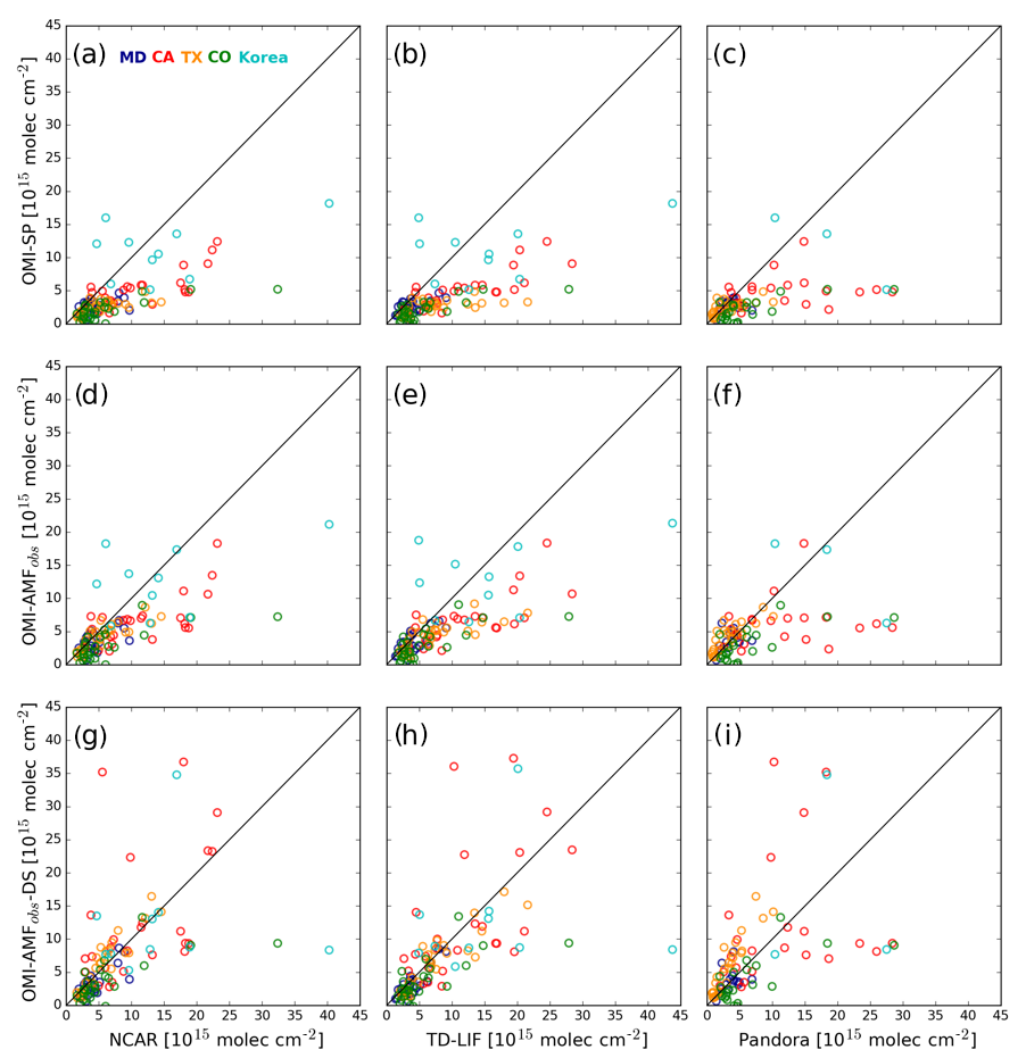
Figure 8. Comparison of tropospheric NO 2 columns from OMI with the data from NCAR (a, d, g) , TD-LIF (b, e, h) , and Pandora (c, f, i) instruments. OMI retrievals are performed using the default GMI (a–c) and observed NO 2 profiles (d–i) . In addition, OMI columns in (g) – (i) are downscaled with high-resolution (CMAQ and/or WRF-Chem) model simulations. Different colors represent the campaign